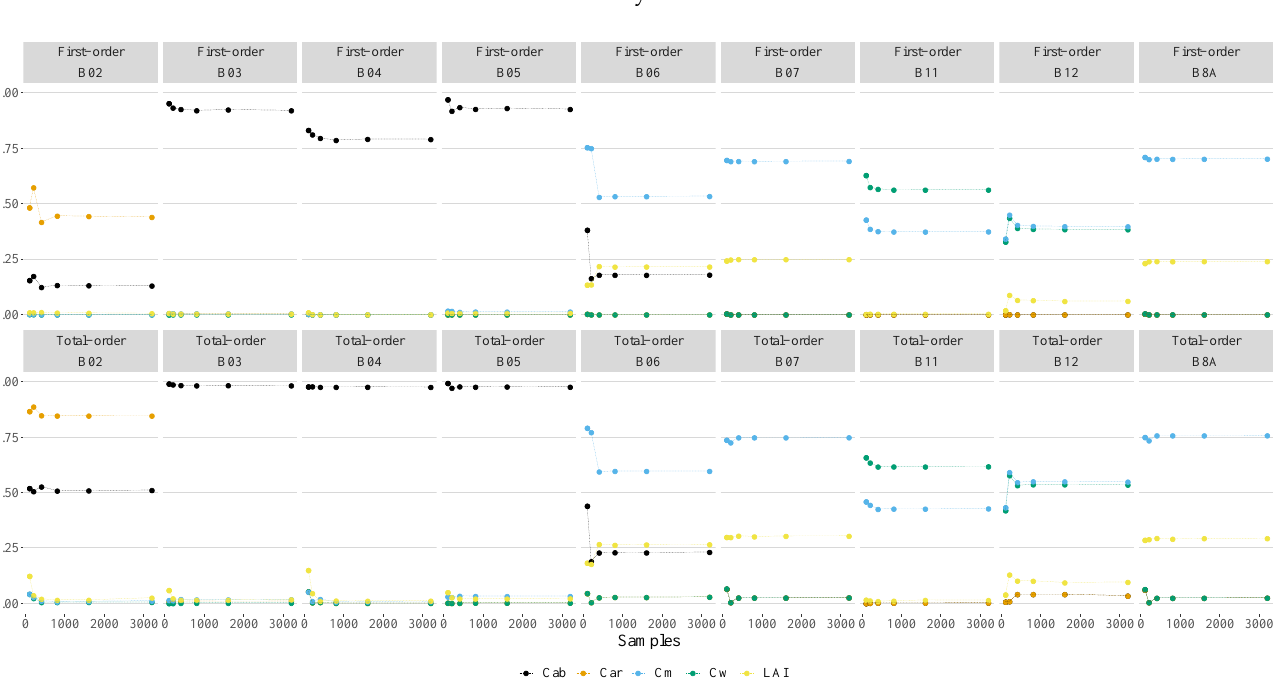
Figure 4. Global sensitivity index EFAST as function of the number of samples.